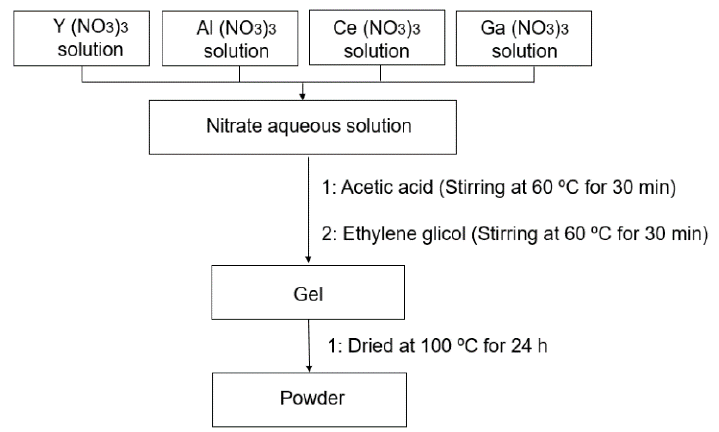
Figure 1 . Schematic flow chart outlining the procedure for the YAG:Ce,Ga NPs preparation. Figure 1. Schematic flow chart outlining the procedure for the YAG:Ce,Ga NPs